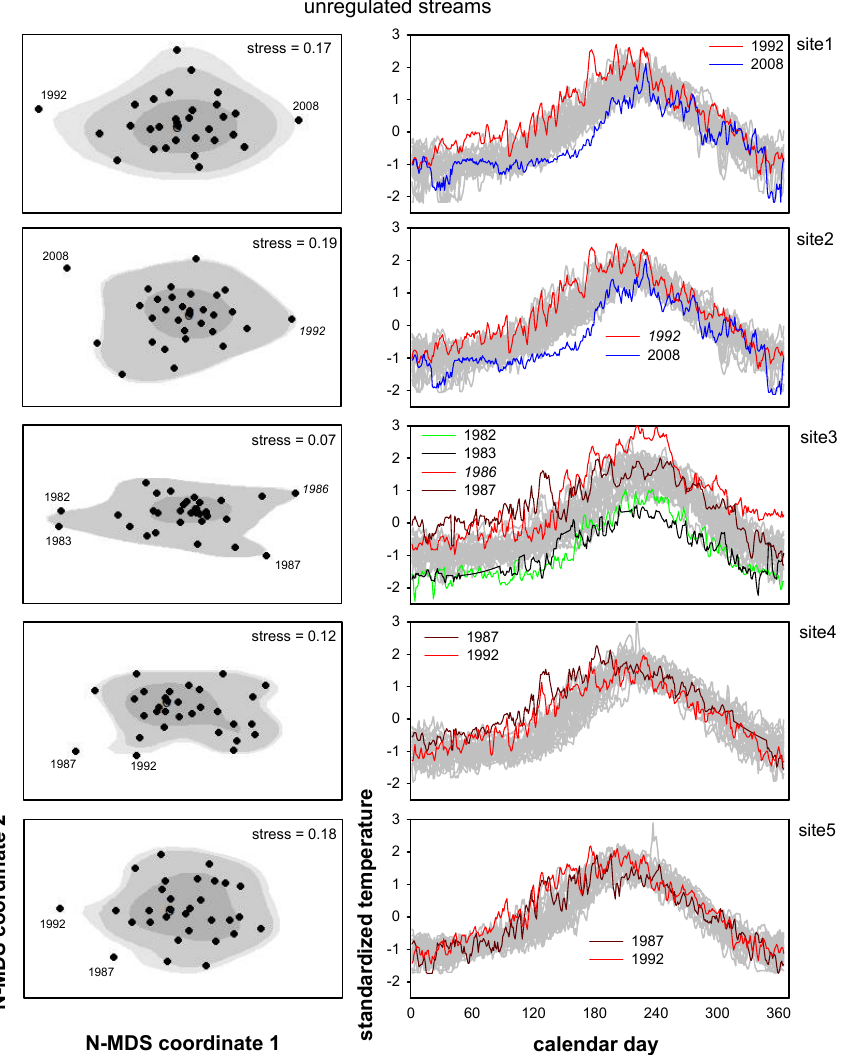
Figure 4. Bivariate HDR boxplots (left panel) and standardized daily temperature distribution (right panel) in unregulated streams using annual time series of daily minimum. The dark and light grey regions show the 50, 90, and 95% coverage probabilities. The symbols outside the grey regions and darker lines represent potentially anomalous years. Examples of years between 90 and 95% of the coverage probability were